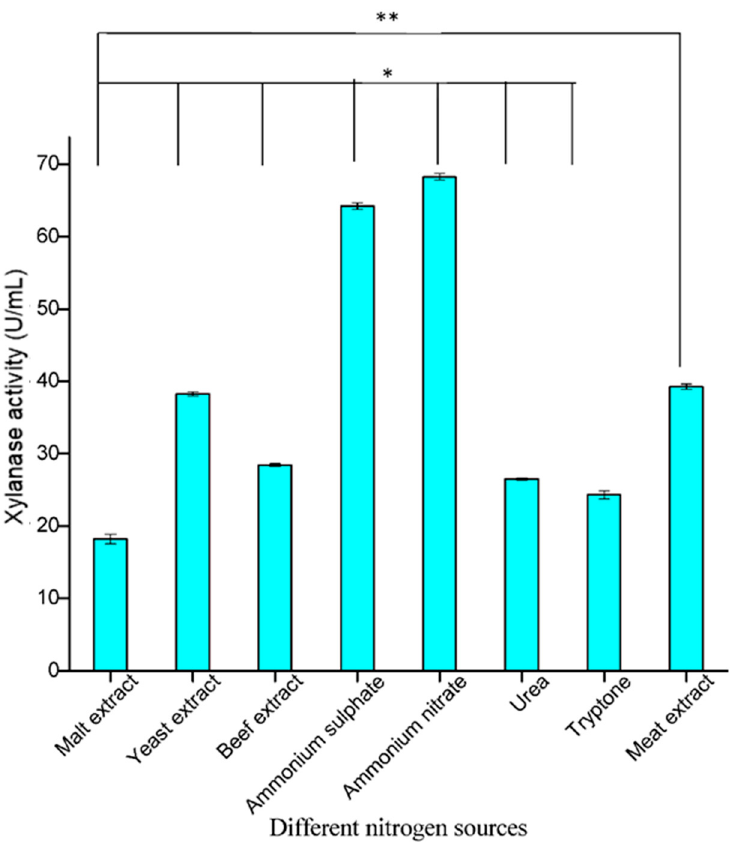
Figure 5. Effect of nitrogen sources on the production of xylanase by B. safensis XPS7 (Medium: M5; temp.: 30 °C; time: 24 h; pH: 8; inoculum: 4%). All the experiments were performed in triplicate. Bars display mean ± SD and statistical analysis was performed using a one-way ANOVA with a Tukey post hoc test, with p < 0.05 ** and p < 0.01 *.